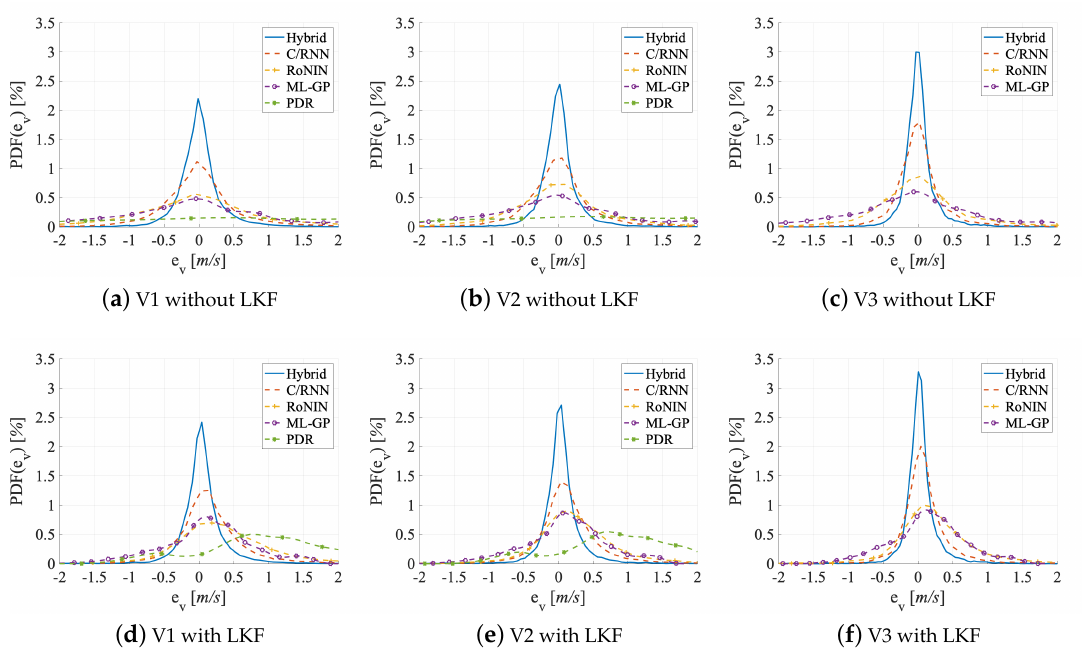
Figure 10. PDF on test sets V1–V3, both without and with